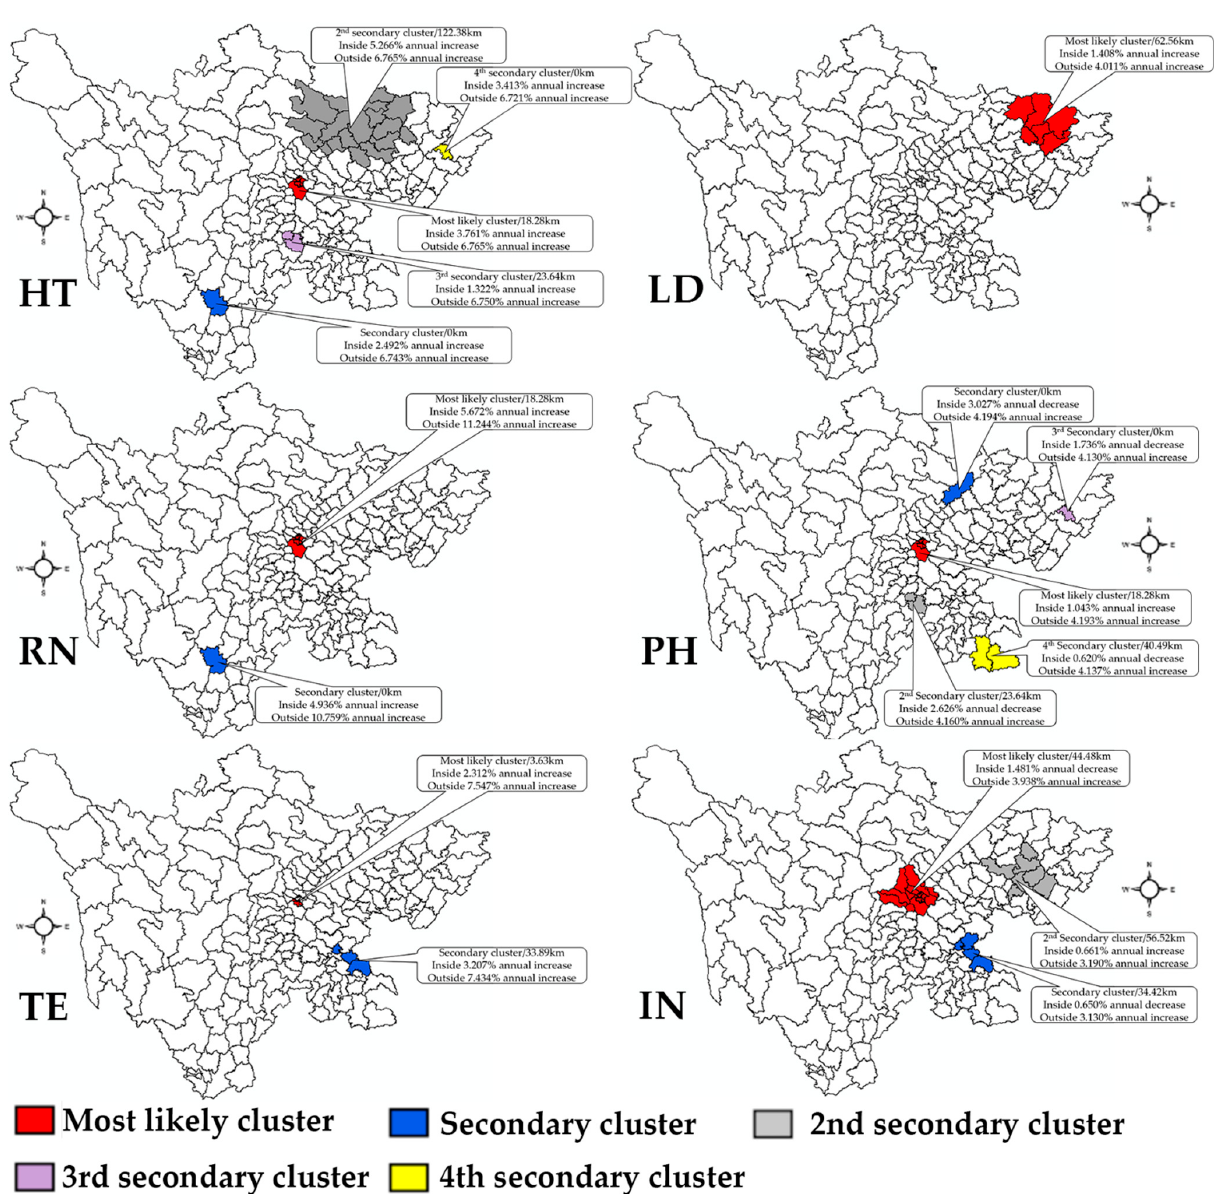
Figure 6. Lower spatial variation in temporal trends. HT, health technician; LD, licensed doctor; RN, registered nurse; PH, pharmacist; TE, technologist; IN, intern.